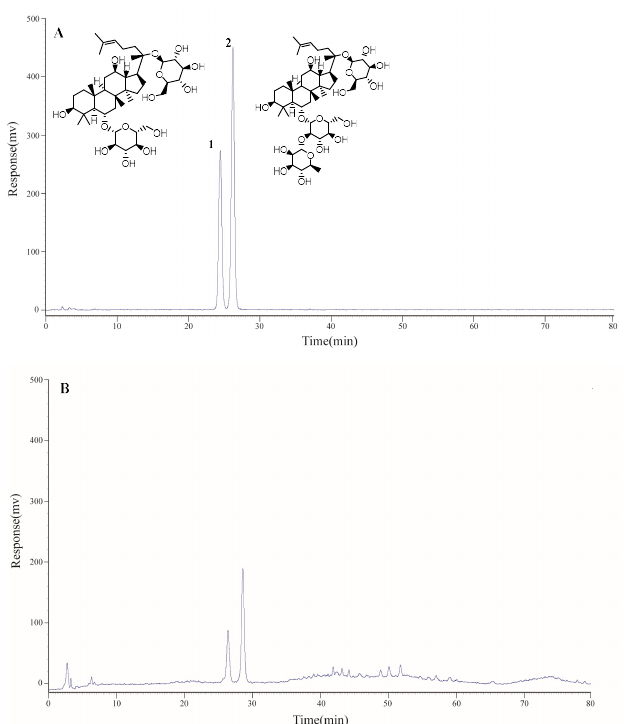
Figure 1. HPLC-ELSD chromatograms of mixed standards ( A ) and PTS ( B ): 1. Ginsenoside Rg1; 2. Ginsenoside Re. Table 1. Contents (%, mean values ± SDs, n = 3) of two compounds in